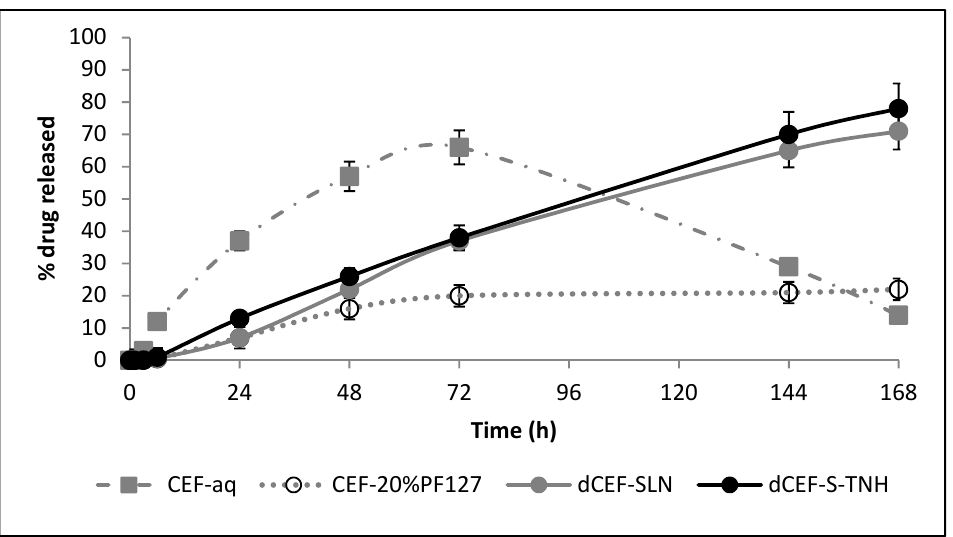
Figure 14. In vitro release test by ocular flow cell of: CEF from aqueous solution (grey dash and dot) and from PF127 20% w/v hydrogel (grey dotted line) or dCEF from SLN (grey solid line) and from S-TNH (black solid line). Each bar represents the mean ± SD ( n = 5). Between the two CEF-containing preparations, significance was found from 0 to 72 h ( p < 0.01) whilst no significant differences were noted for the end-points ( p > 0.05). Comparing dCEF-SLN and dCEF-S-TNH with CEF-20%PF127, significance was observed from 72 to 168 h ( p < 0.01). No significant differences were observed between dCEF-SLN and dCEF-S-TNH ( p > 0.05).